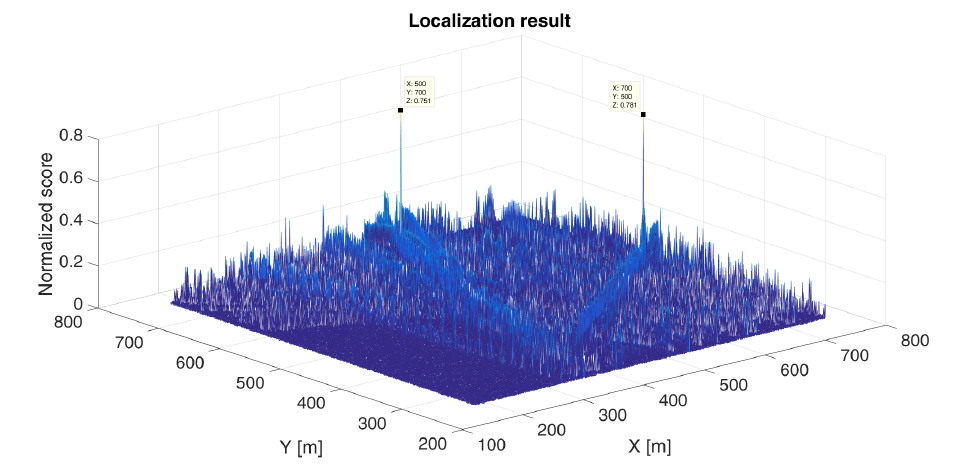
Figure 11. The localization results of the 10-th and 4-th source, i.e., the 8-th impulse in the reference channel—3D